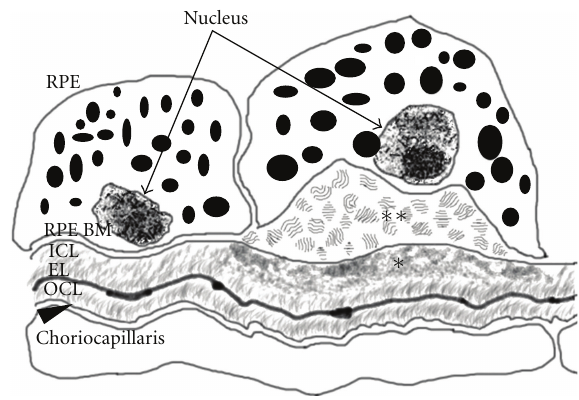
Figure 3: Schematic image of the RPE-Bruch’s membrane- choriocapillaris interface in AMD. Basal laminar deposits (BlamDs; ∗∗ ) appear between the RPE cell and the RPE basement membrane (RPE BM), while basal linear deposits (BlinDs; ∗ ) localize at the inner collagenous layer (ICL) beneath the RPE basement membrane. EL: elastin layer; OCL: outer collagenous layer; arrowhead indicates endothelial cell basement